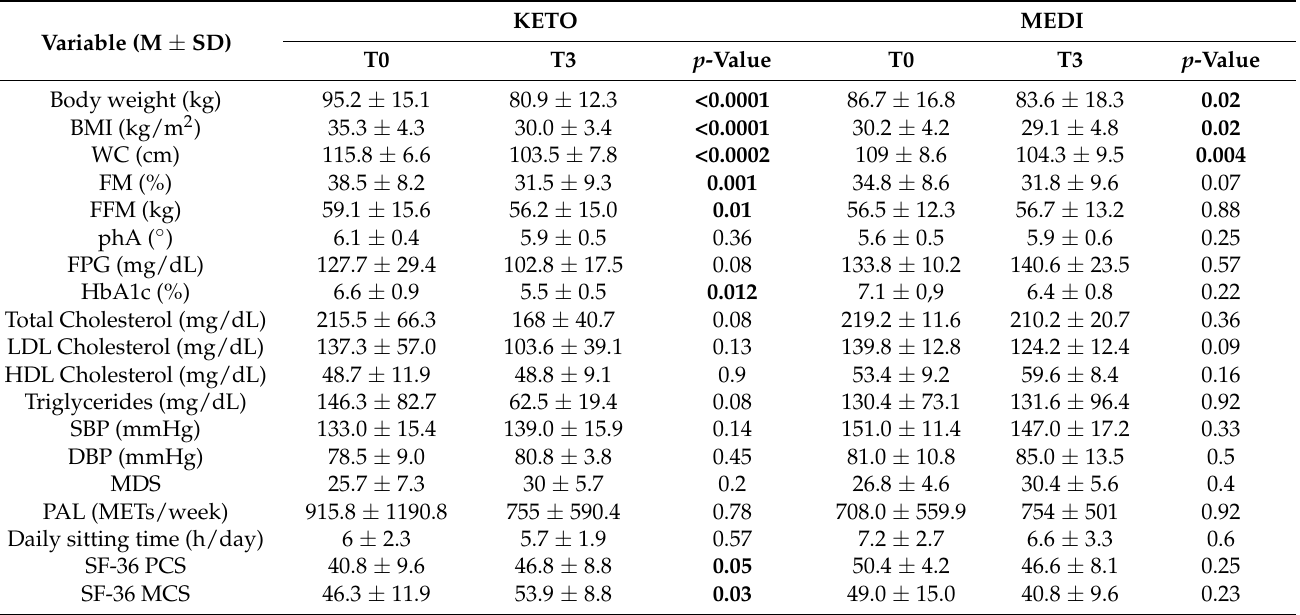
Table 2. Anthropometric, metabolic, lifestyle, and health status evaluation in KETO and MEDI groups at T0 and T3.